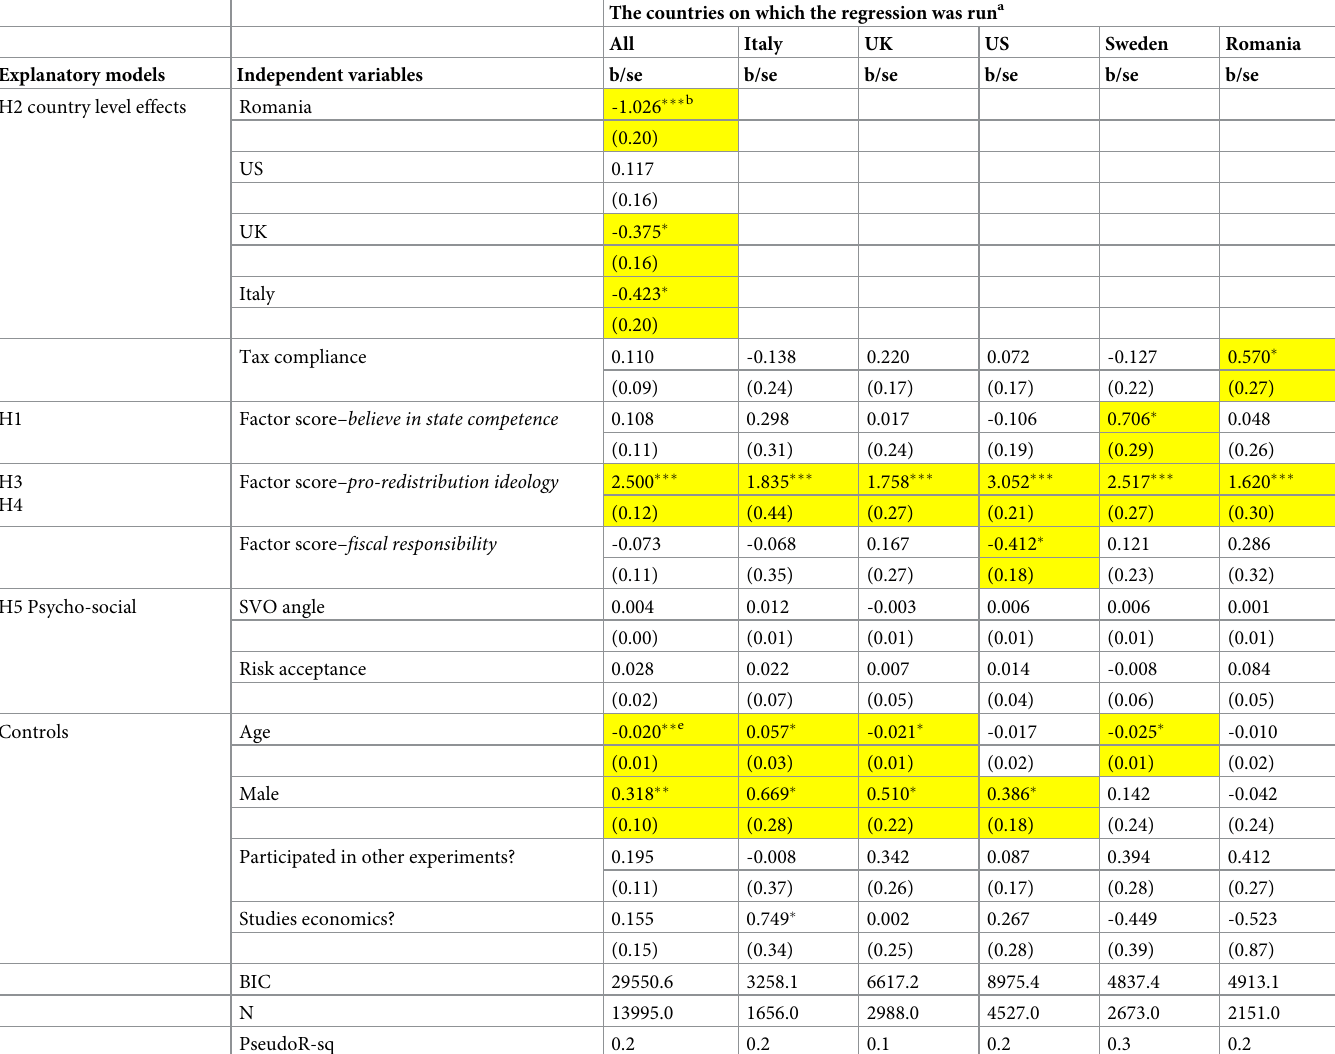
Table 1. Explanatory models for the preferences for more or less government spending on the